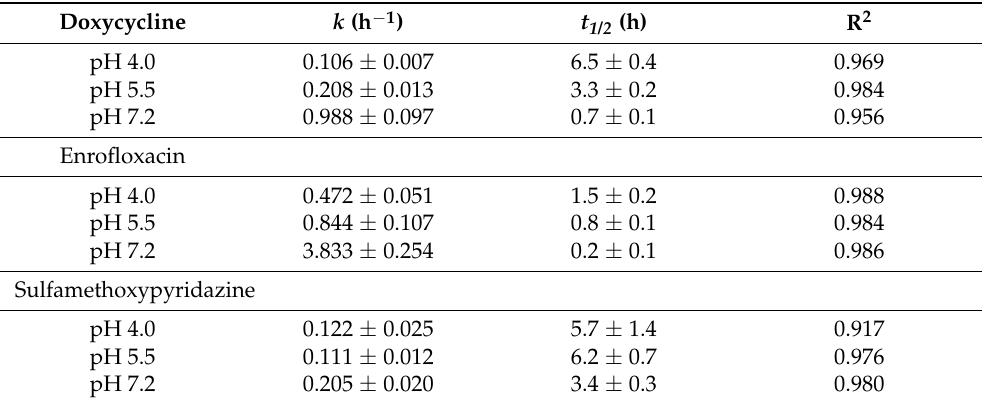
Table 1. Results of the exponential decay model (Equations (1) and (2)) in samples prepared with filtered milliQ water (FMW) at different pH values; k : rate constant (h − 1 ); t 1/2 : half- life (h). Average values ± standard error. Doxycycline k (h − 1 ) t 1/2 (h) R